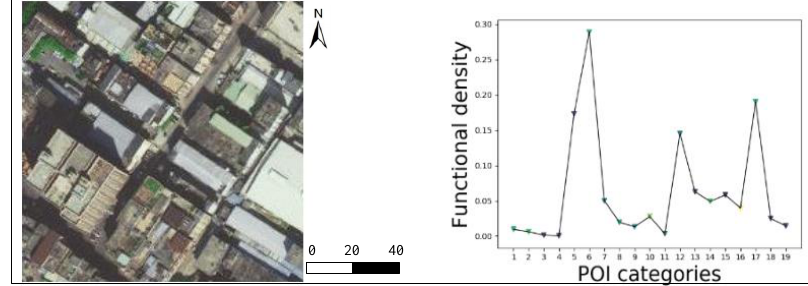
Figure 7. Different urban functional regions would be similar in shape, color or texture of remote sensing images, but totally different in POI distribution. These urban regions would be confused by remote sensing images, but clearly differentiated by POI